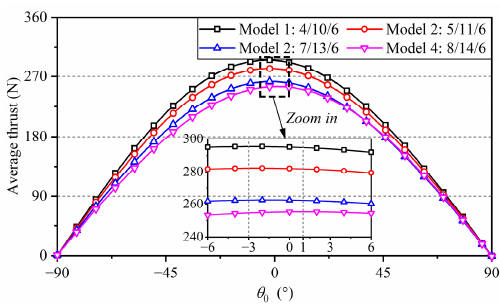
Figure 11. Average thrust variation with phase current angle.